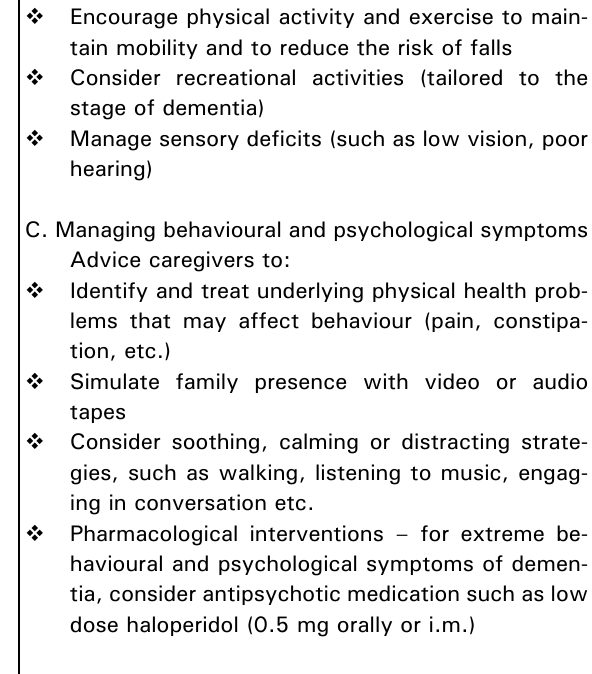
Table 2. Post-diagnostic education and training protocol for dementia